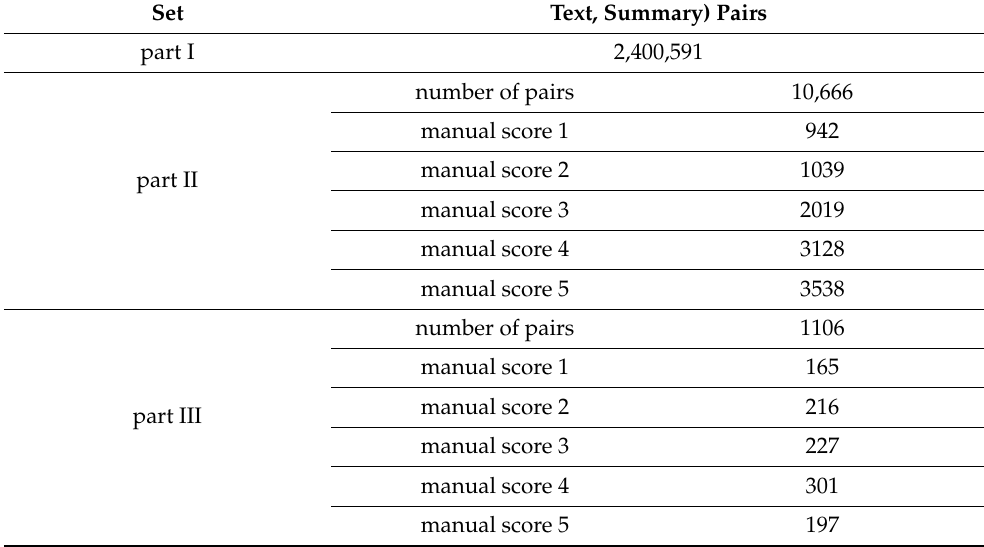
Table 2. Statistics of